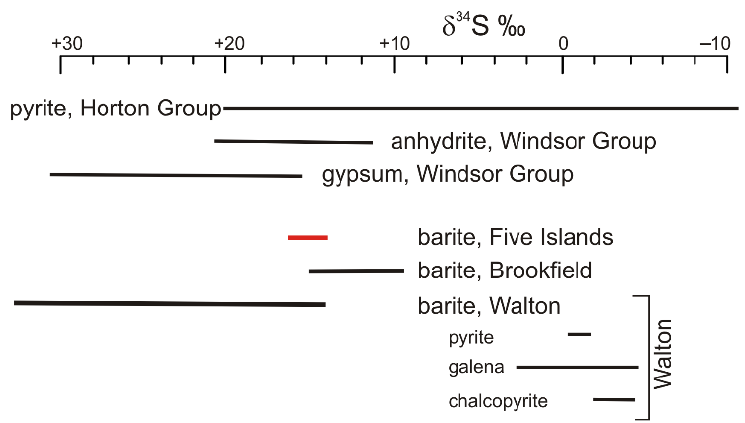
Figure 9. Sulfur isotope composition of barite and comparative rocks. Data from Cobequid Highlands from this study; for central Nova Scotia from [23,24].